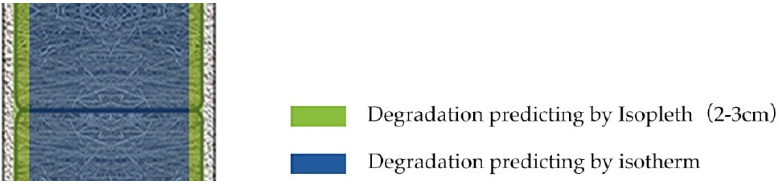
Figure 15. Critical factors for straw degradation inside straw bale walls.